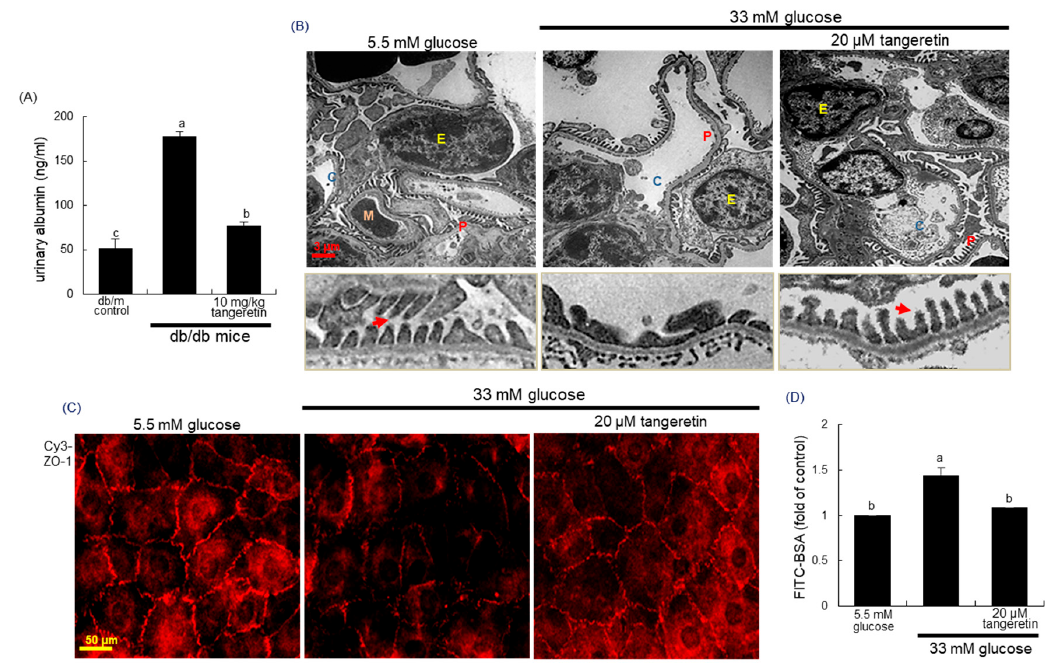
Figure 4. Effects of tangeretin on mouse urinary albumin excretion ( A ) and structural changes